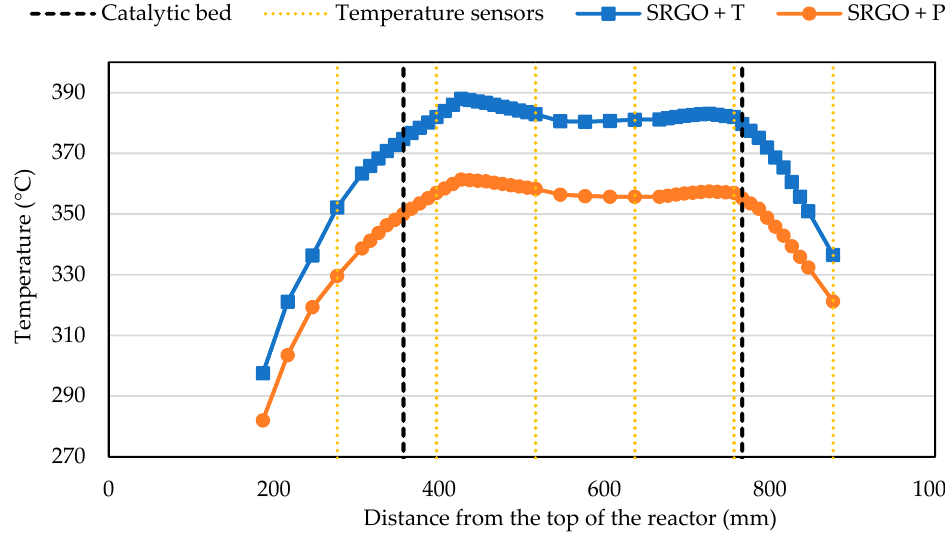
Distance from the top of the reactor Figure 4. Temperature profile for the Co-processing. Figure 4. Temperature profile for the